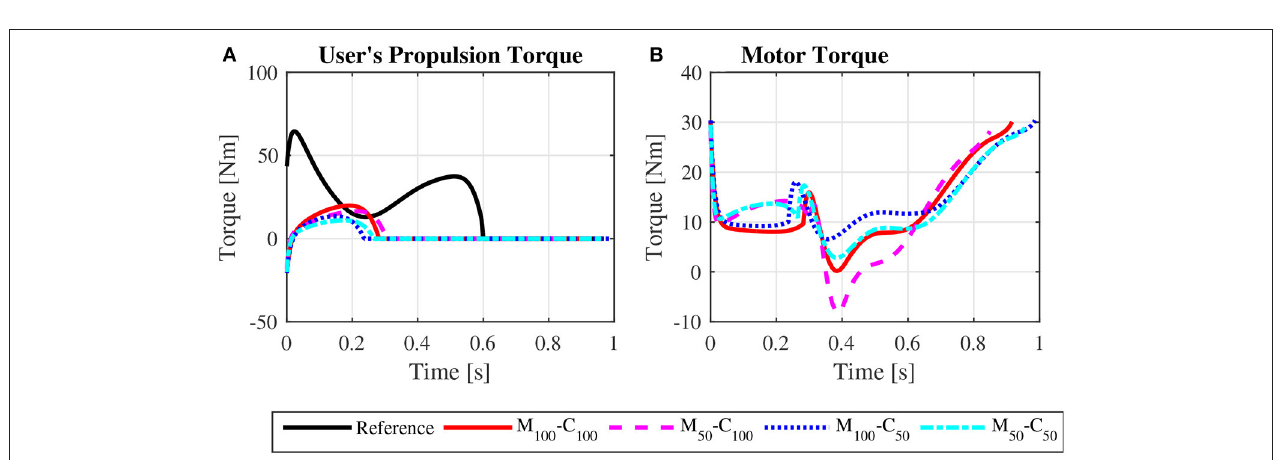
FIGURE 10 | Bilateral propulsion torque applied by the user (A) and bilateral torque applied by the motors on the rear wheels of the wheelchair (B) for steady state locomotion on a 3 ◦ ramp at an average speed of 0.9 m/s for the reference unassisted condition (Reference), and for the assisted locomotion with 100% of reference model parameters M i and C i ( M 100 − C 100 ), reduction of 50% in M i ( M 50 − C 100 ), reduction of 50% in C i ( M 100 − C 50 ), and reduction of 50% in M i and C i ( M 50 − C 50